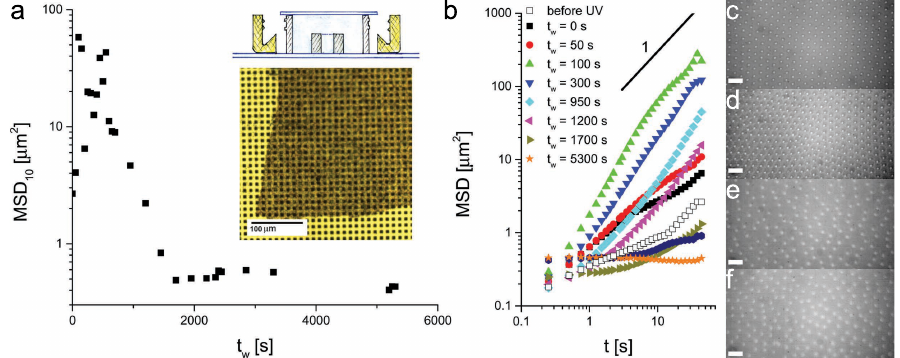
Figure 7. ( a ) MSD calculated after 10 s for 2.8 µ m PS particles at a water–decane interface during the interfacial photopolymerization of polystyrene as a function of time after starting the UV illumination t w . Top inset: schematics of the sample cell. Bottom inset: micrograph of a composite PS particle-polystyrene membrane deposited onto a pitted silicon wafer with 5 × 5 µ m 2 cavities; ( b ) MSD versus time for different representative times during the photopolymerization; ( c–f ) fluorescence images of the 2.8 µ m PS particles at the interface before UV illumination ( c ) and after 50 s ( d ), 40 ( e ) and 90 ( f ) minutes. Scale bar: 25 µ